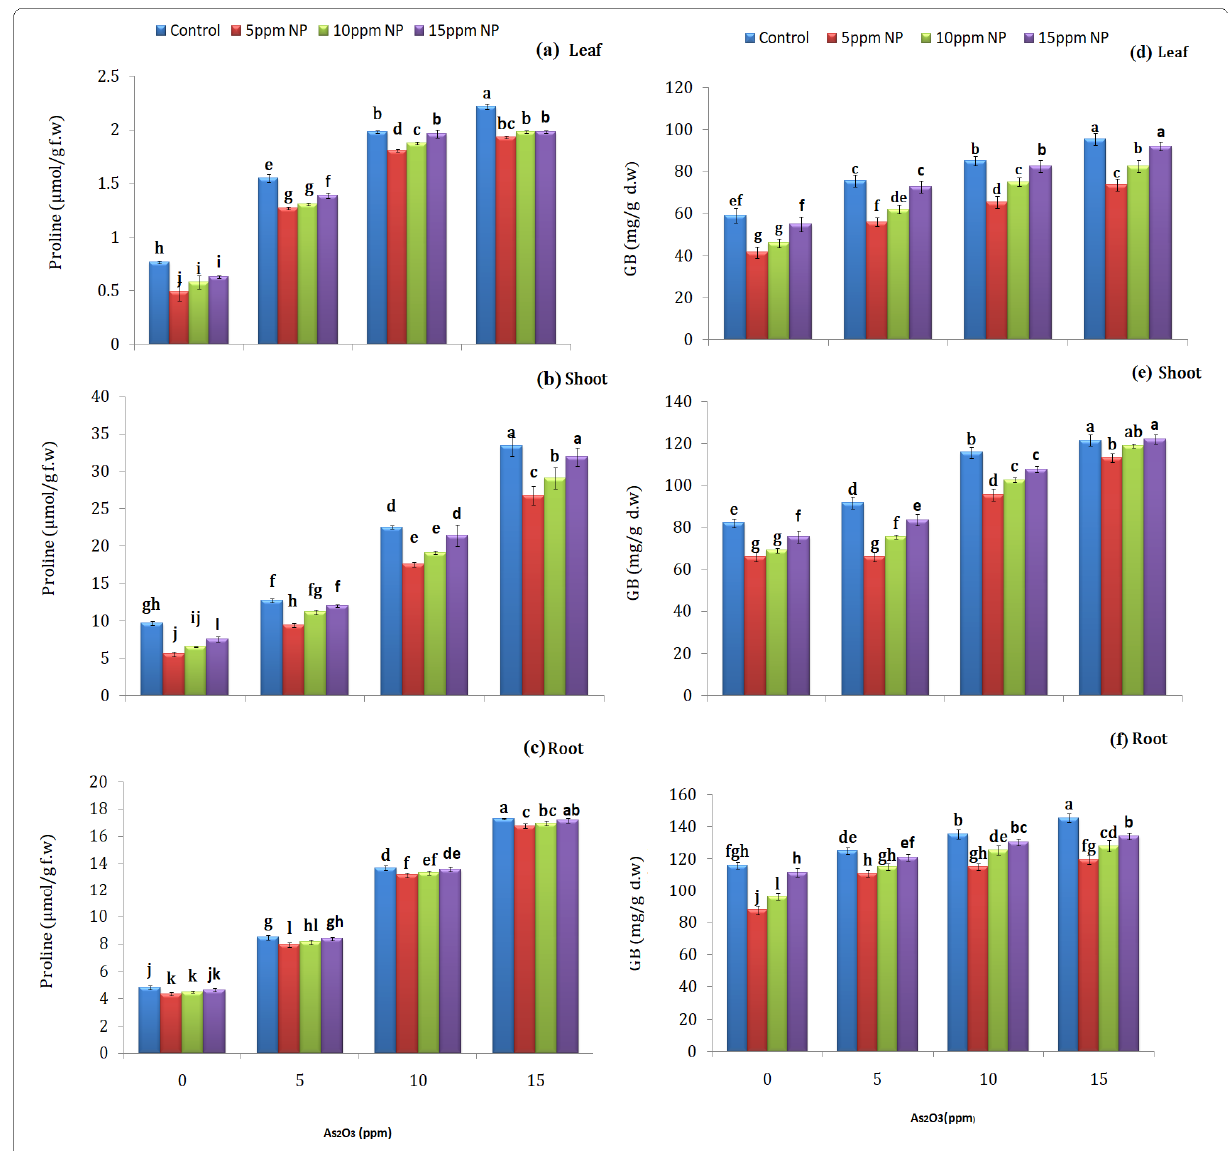
Figure 3. Effect of Bacillus subtilis synthesized iron oxide nanoparticles on proline ( a – c ) and Glycine betain ( d – f ) content of rice ( Oryza sativa L.) in arsenic-contaminated water. Different letters indicate significant differences ( p < 0.05) between